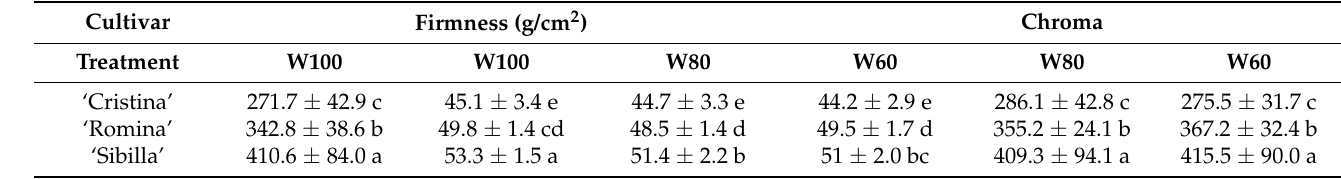
Table 14. Effects of water availability on fruit firmness and chroma in different strawberry cultivars. Values with the same lowercase letter for the same parameter were not statistically different for Fisher’s LSD test ( p < 0.05). Values are expressed as means of two years (2017–2018) ± standard deviation (SD).